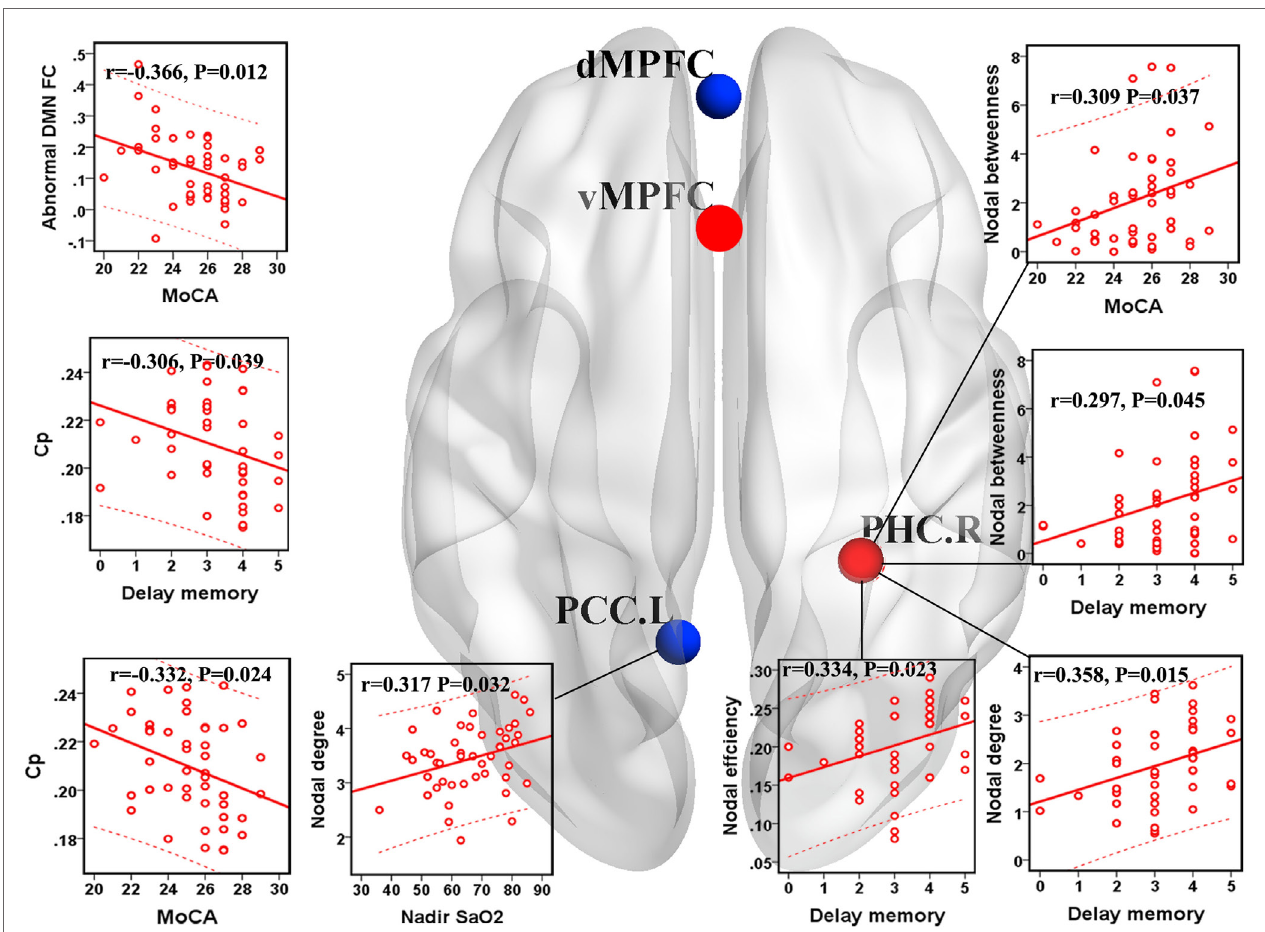
FigUre 6 | Correlations between network measures with group differences and clinical variables in patients with obstructive sleep apnea (OSA). Scatter plot showed the relationship between the aberrant network attribute parameters and clinical index in patients with OSA. The red ball represents the increased nodal centrality and the blue ball represents the decreased nodal centrality. E loc , local efficiency; C p , clustering coefficient; PCC.L, left posterior cingulate cortex; PHC.R, right parahippocampal